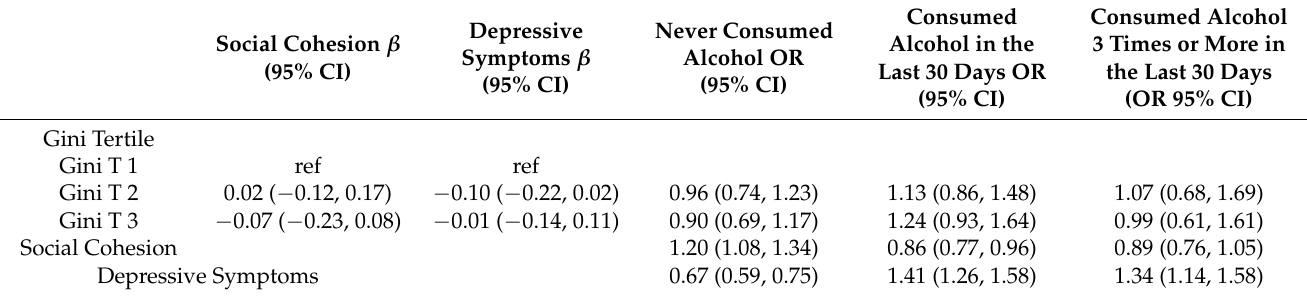
Table 3. Bivariate analysis of the relationships between social cohesion and depressive symptoms, as potential mediators, and income inequality and alcohol consumption among boys and girls: 2008 Boston Youth